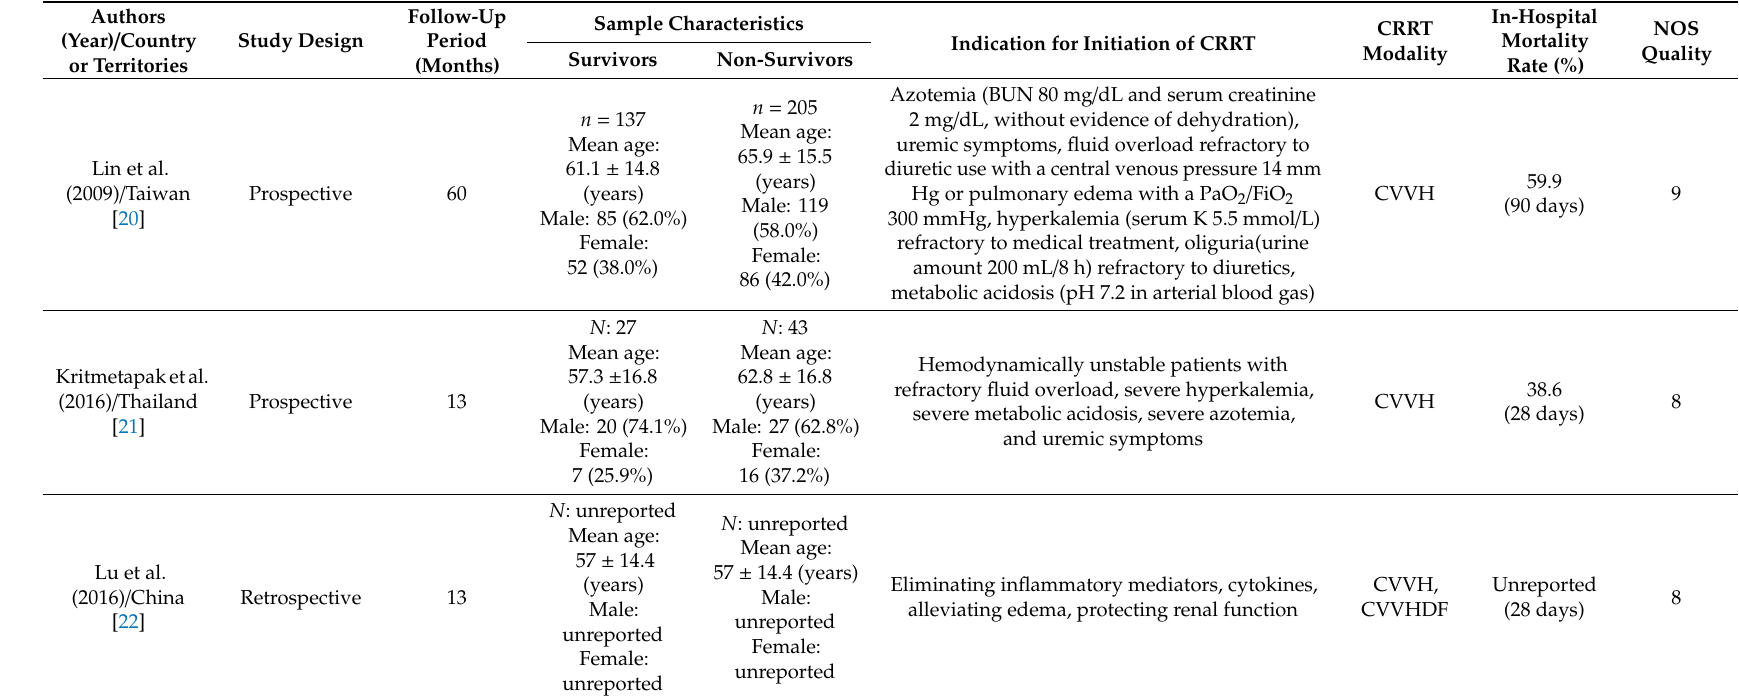
Table 1. Characteristics of studies included ( N =